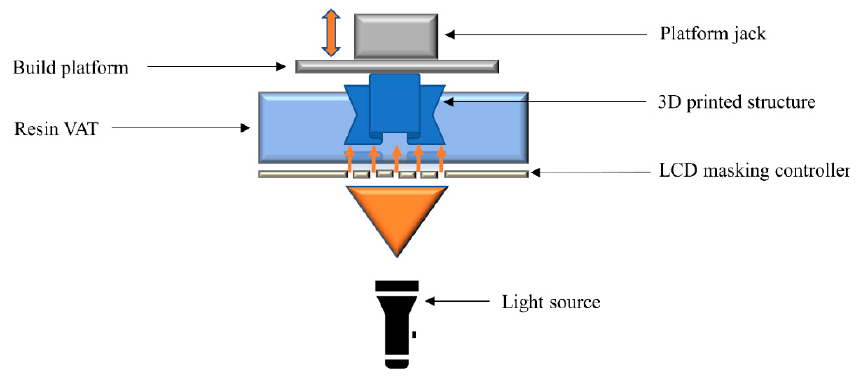
Figure 7. Schematic diagram of the liquid crystal display (LCD) printing